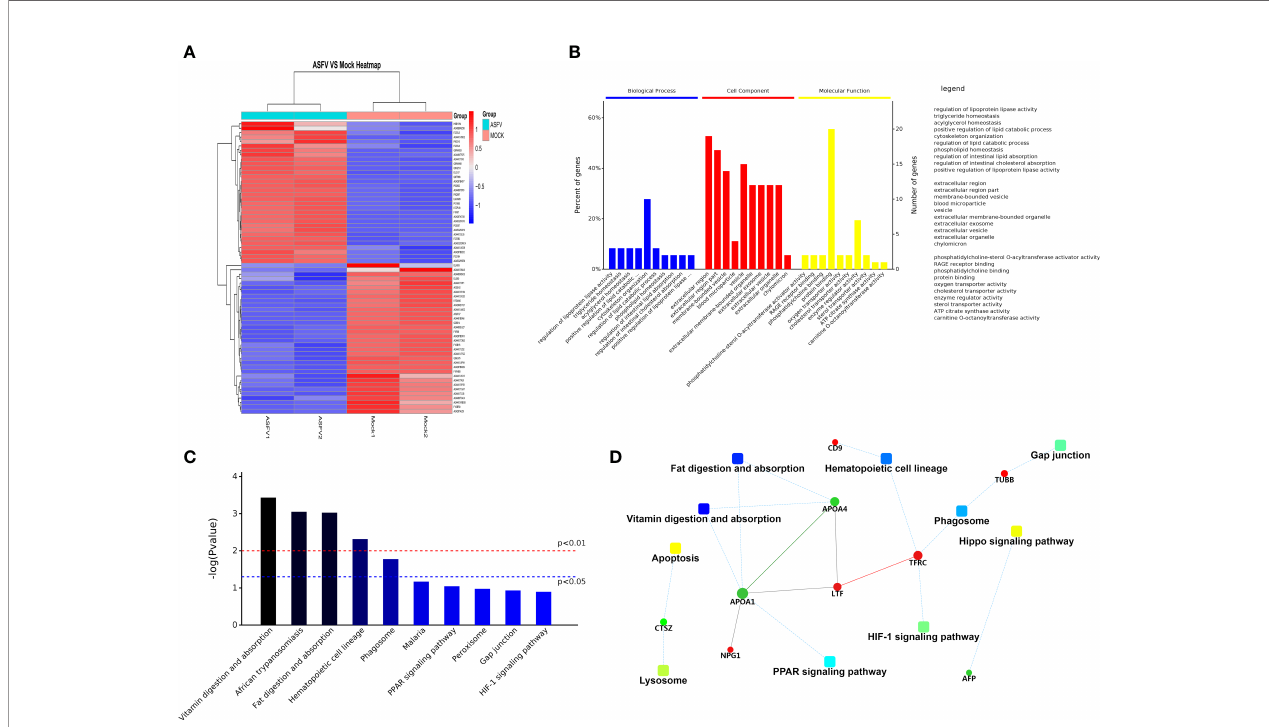
FIGURE 3 | Differentially expressed protein analysis. (A) Differential protein cluster analysis, grouping, and categorizing data based on similarity using a clustering algorithm to classify samples and variables in two dimensions. The results show whether changes in the expression of the target proteins signi fi cantly impact the samples ’ biological processing. The clustering of the target proteins distinguished proteins with different expression patterns. A subset of proteins with similar expression patterns may have a similar function, participate in the same biological pathways, or maybe be in an adjacent regulatory position in the pathways. (B) GO annotations for differential proteins representing Biological Process, Molecular Function, and Cellular Component. The signi fi cant enrichment analysis of GO annotations was used to evaluate the signi fi cance level of a certain GO terms enrichment by Fisher ’ s exact test. (C) Based on all qualitative proteins as the background, Fisher ’ s exact test was used to analyze and calculate the signi fi cance level of protein enrichment for each KEGG pathway and determine the metabolism and signaling that are signi fi cantly affected. (D) The dashed/solid line represents the con fi dence score. The default minimum value was 400, the solid line represents the larger value, the dashed line represents the smaller value, the round dot represents the protein or gene, red represents upregulation, and the green represents green down-regulation. A circle gray dot represents the comparison of more than 3 groups in which we could not obtain upregulation and down- regulation information. A giant node represents the KEGG pathway/Biological process. A yellow-blue gradient represents a signi fi cant P -value, yellow represents a small P -value, and blue represents a large P -value. The higher the score for each connection point, the more reliable the